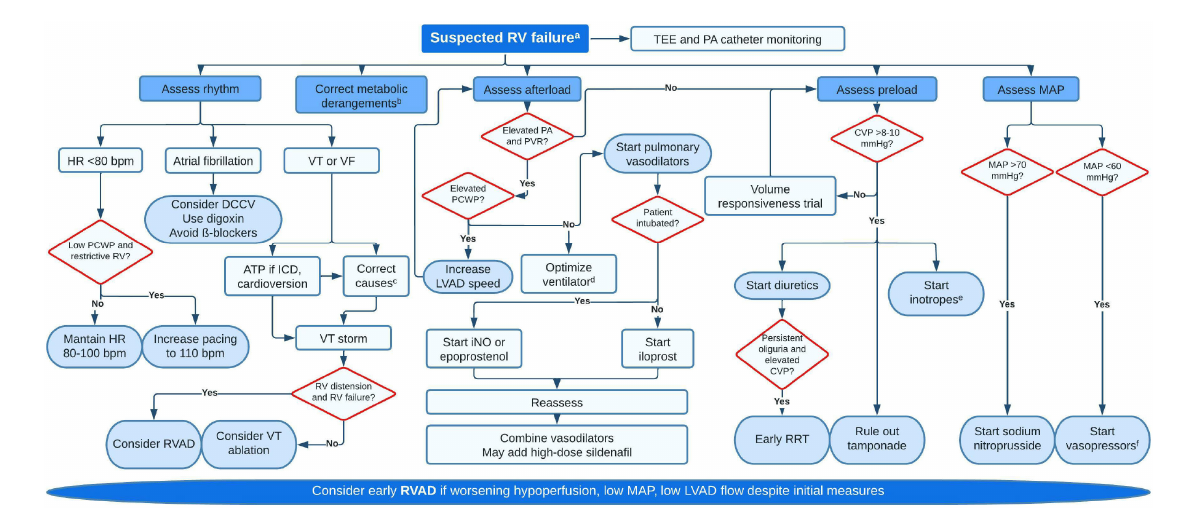
FIGURE7 Proposed algorithm for management of early right ventricular failure. a Signs of hypoperfusion (lactate > 2 mmol/L, MAP < 60 mmHg, drop in pump flows, mottled skin, oliguria) supported by hemodynamic (CVP > 15, PAPI < 1, RV stroke work index < 300, CI < 2 ml/min/m 2 , mixed venous oxygen saturation < 50%), echocardiographic (dilated RV, leftwards septal bulge, severe TR, fixed and distended IVC) or laboratory data (rise in creatinine, blood urea nitrogen or liver enzymes). b Correct hypoxemia (if significant, rule out intracardiac shunts), hypercarbia and acidosis. c Common causes for VT are metabolic derangements b , ischemia (supply demand but also direct damage during surgery), pacing-related issues, scar-mediated or suction events. d Aim for low positive end-expiratory pressure (just enough to minimize atelectasis), low mean airway pressure and avoid air entrapment. Plan for early extubation if possible. e Milrinone (0.125–0.75 µ g/kg/min) is usually preferred to dobutamine or epinephrine given their deleterious on PVR. Low dose dobutamine (2–5 µ g/kg/min) may not affect PVR. Epinephrine can be used if patient is hypotensive. f Norepinephrine (0.01–0.5 µ g/kg/min) is the most used pressor, but vasopressin (0.01–0.06 U/min) should be added at low dose as it has less vasoconstrictive effect on the pulmonary vasculature. RV, right ventricular; TEE,